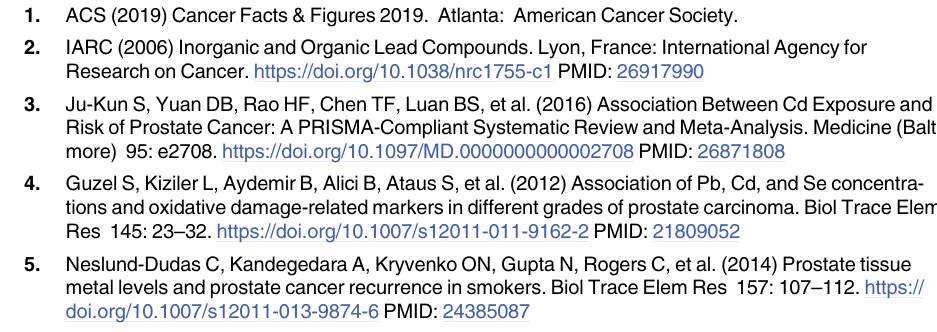
S1 Table. Associations between urinary levels of total arsenic and dimethylarsonic acid and elevated Serum PSA among NHANES Men, after removing the effects of